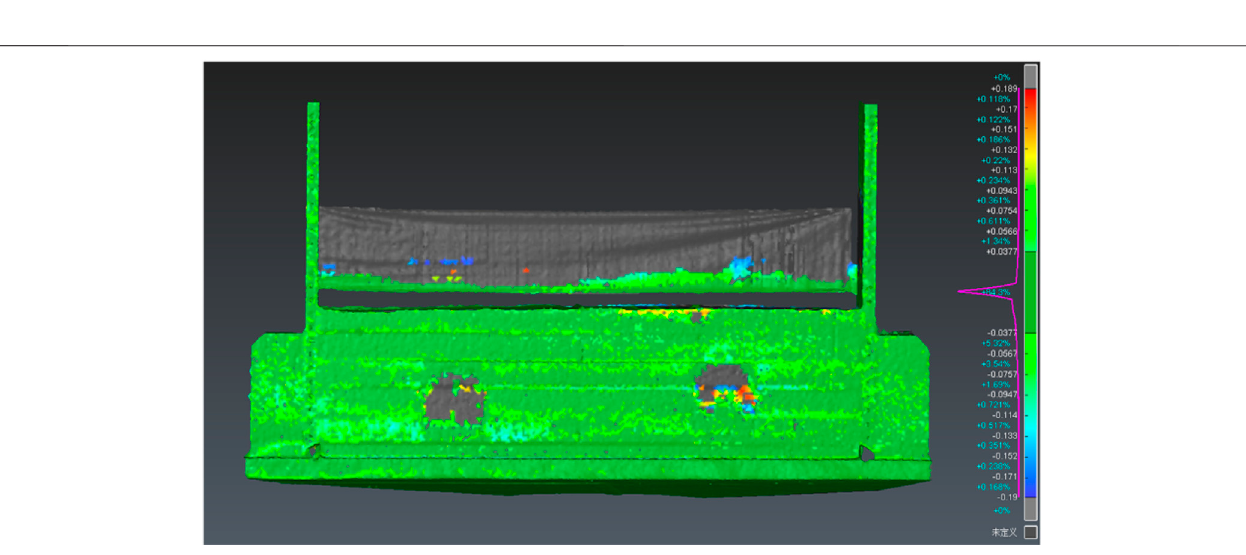
FIGURE 7 | Cloud map of surface collapse and